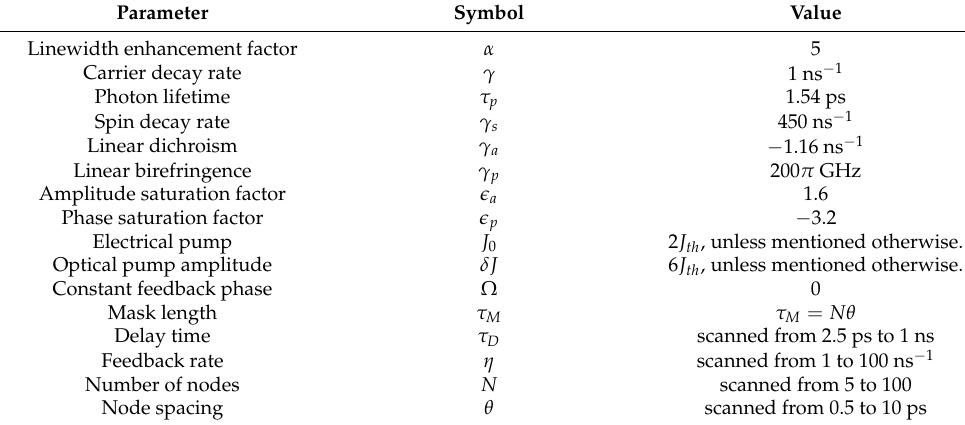
Table 1. List of paramaters, designation and values used in the simulations for delay-based RC using the